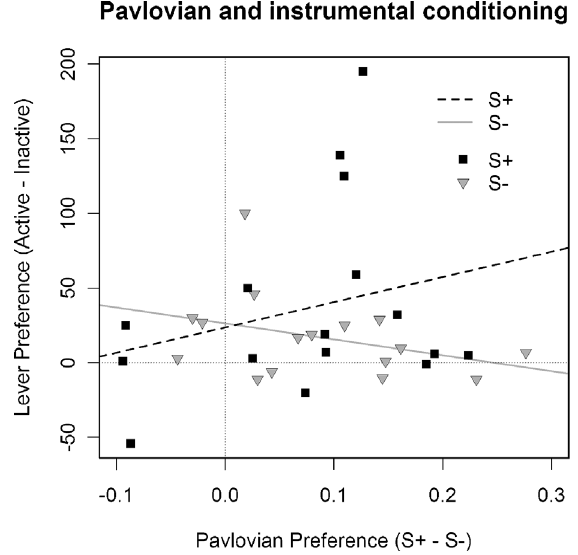
Figure 4. Correlation between Pavlovian discrimination and instrumental performance in Experiment 3. The difference in performance during the S þ and S (cid:1) stimuli during Pavlovian conditioning was compared with the difference between S þ and inactive lever responding in Groups S þ and S (cid:1) and inactive lever responding in Group S (cid:1) . This figure illustrates these correlations for each subject of these two groups together with the linear regression line: For Group S þ : r ¼ 0.26, whereas for Group S (cid:1) it